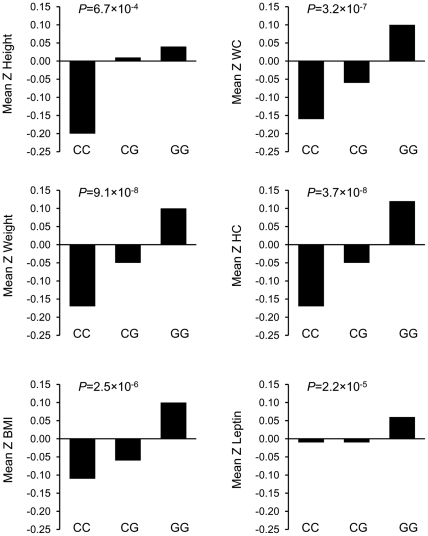
Association of rs2796749 with clinical traits in urban Indian children.Mean Z-scores adjusted for age and sex are plotted on the y-axis for the corresponding genotypes on x-axis for all the traits except leptin for which the mean Z-scores are adjusted for age, sex and Z-BMI.P values presented were determined by linear regression analysis for Z-score change per risk allele of the respective trait.